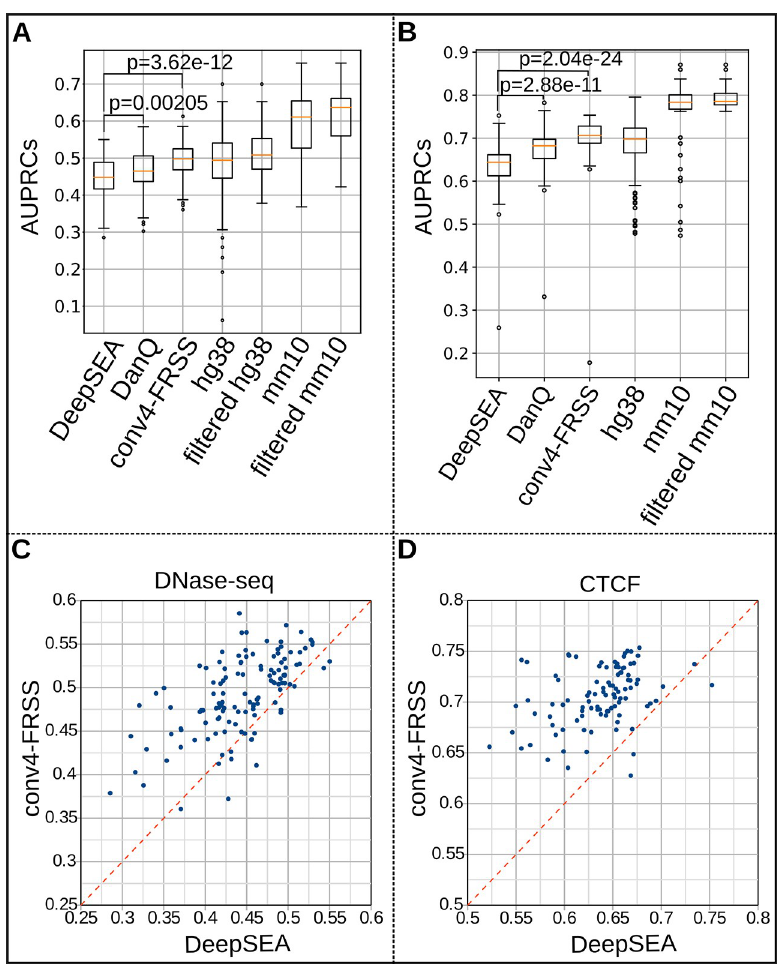
Fig 2. Performance analyses of models with extended datasets. (A, B) Comparison of AUPRCs of DNase-seq data (A) and CTCF data (B), respectively. The scores of DeepSEA and DanQ are obtained from their original studies. conv4-FRSS. hg38 and mm10 are the scores of conv4-FRSS with newly created training data using datasets obtained from the ENCODE project. filtered hg38 and mm10 are the prediction scores of conv4-FRSS trained with high-cFRiP datasets. p, two-sided Mann–Whitney–Wilcoxon test. Boxes, the lower to upper quantile values of the data; orange lines, the median; whiskers, the range of the data (Q1 –IQR × 1.5 and Q3 + IQR × 1.5 for the lower and upper bounds, respectively); flier points, those past the end of the whiskers. (C, D) Scatter plots of AUPRCs of DeepSEA (x axis; scores are obtained from its original data) and conv4-FRSS (y